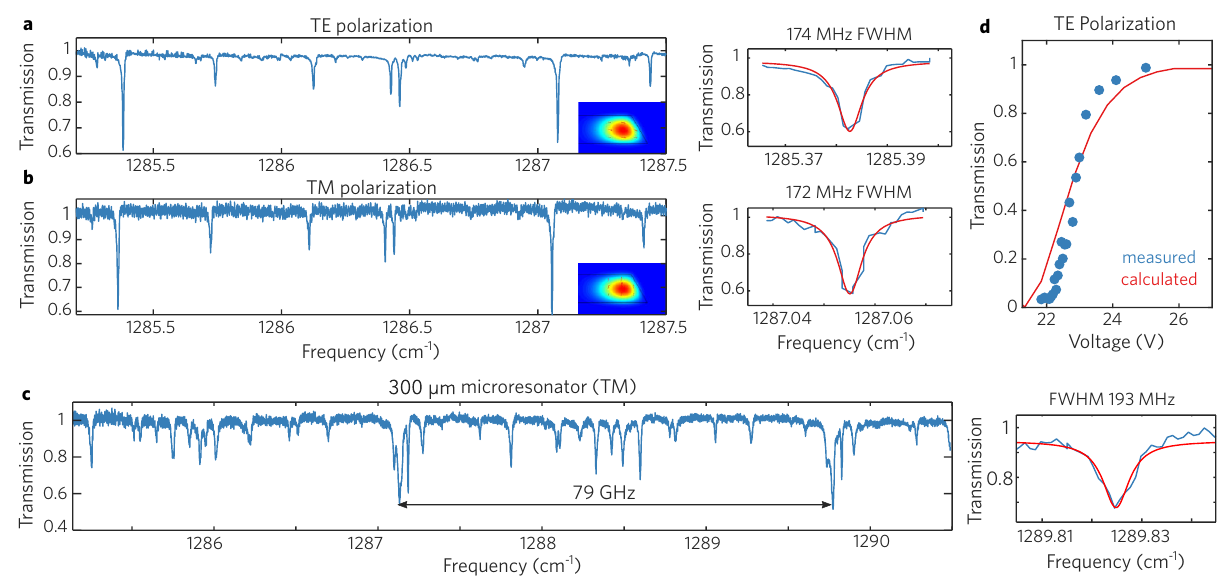
Fig. 4 | Polarization-dependent coupling measurements. a TE polarization transmission of microresonator from Fig. 1a, with a FWHM linewidth of 174 MHz. b TM polarization transmission of microresonator from Fig. 1a, with a FWHM linewidth of 172 MHz. c Transmission measurement of a second WGM micro- resonator with diameter of 300 μ m using laser of TM polarization, with a FWHM linewidth of 193 MHz. d Trend of transmission (TE polarization) versus the